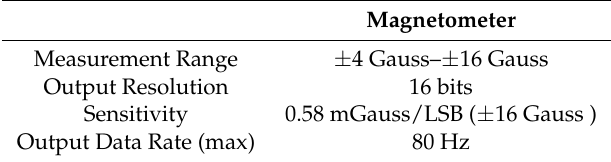
Table 2. Basic performance characteristics of the LSM9DS1 SiP